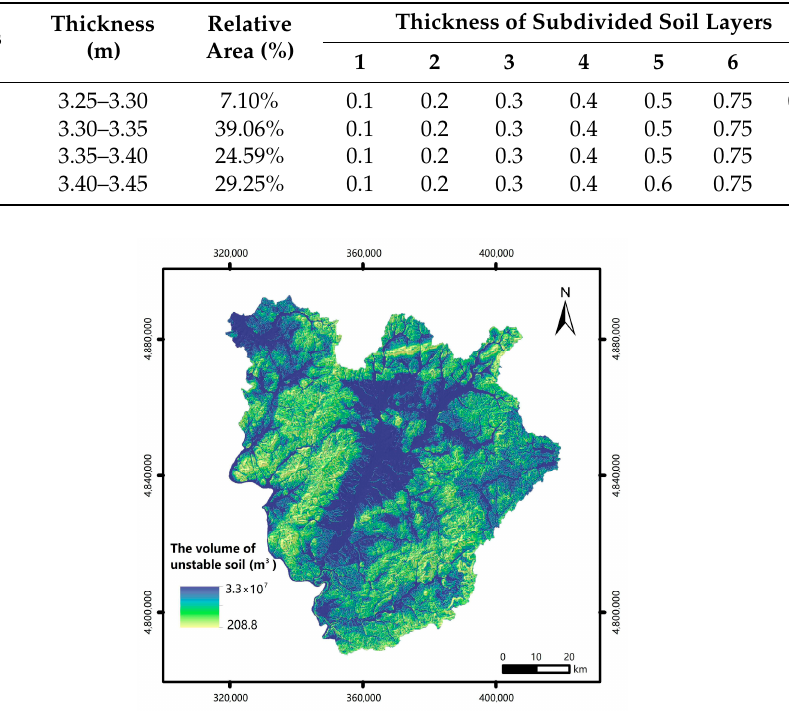
Figure 9. The volume of unstable soil mass using the traditional 2D model.